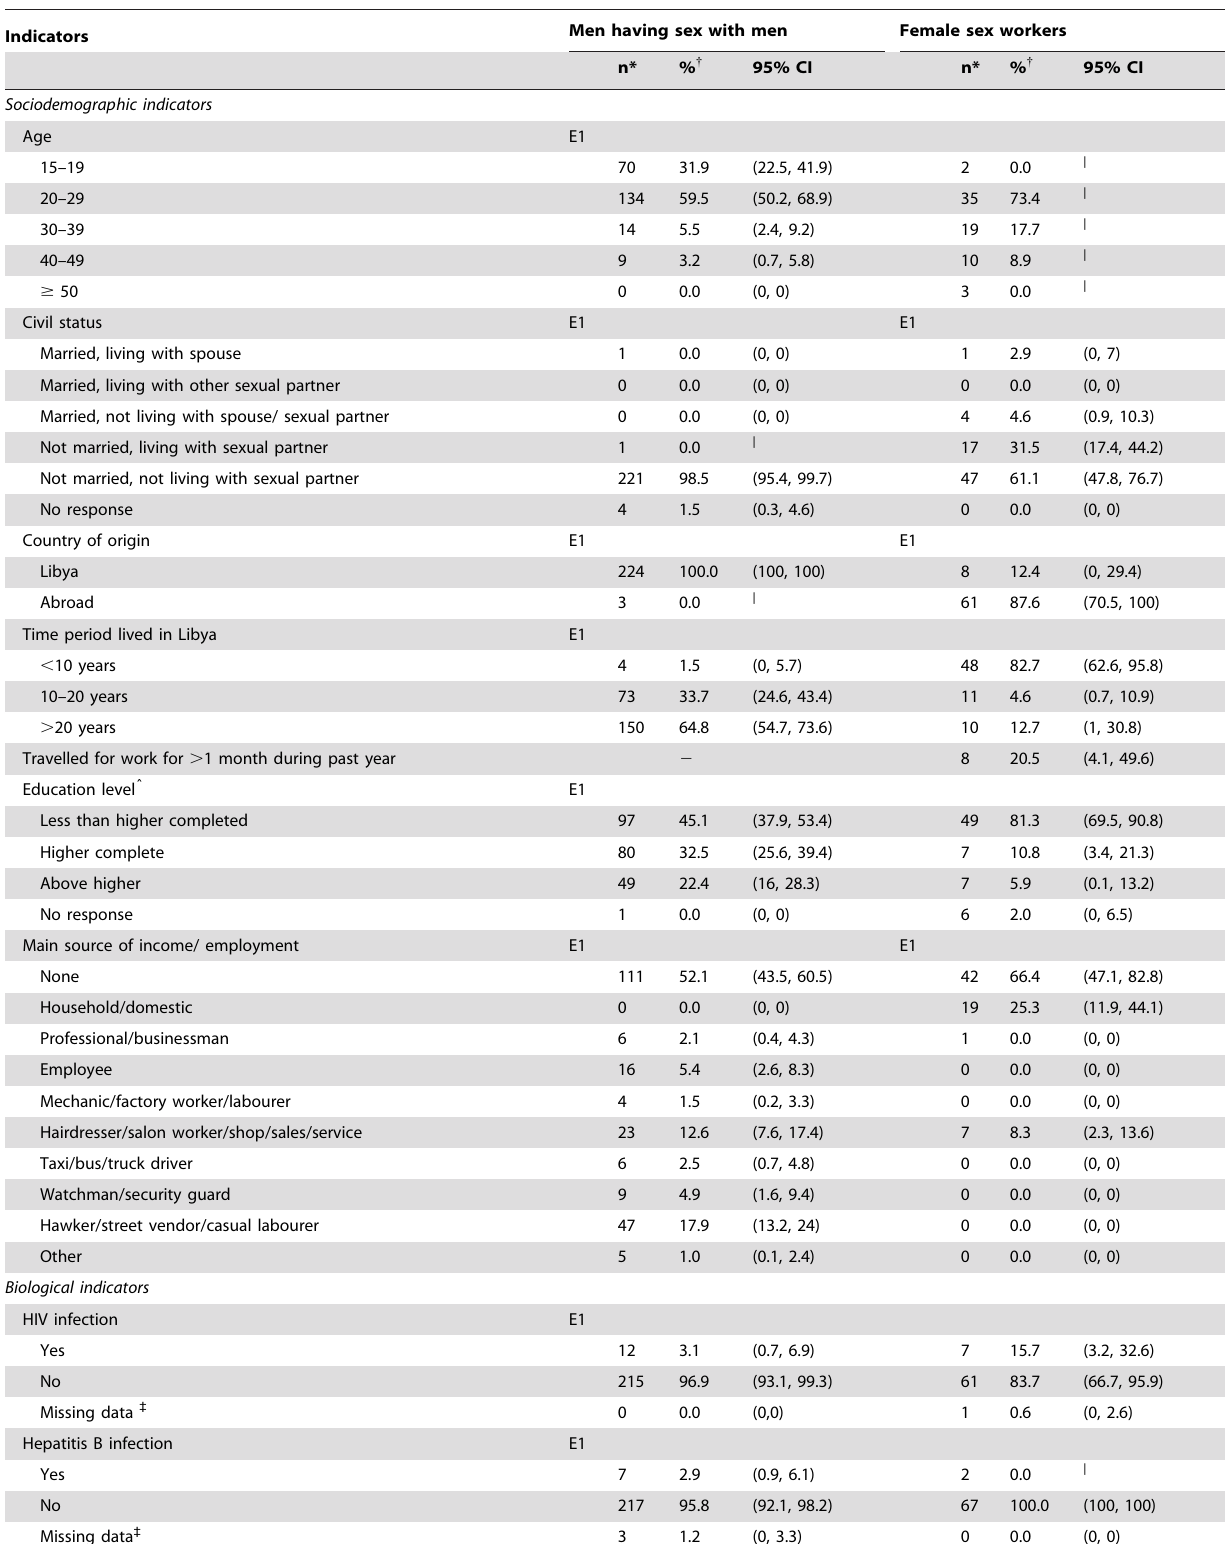
Table 1. Socio-demographic characteristics and prevalence of HIV and other infections among MSM and FSW in Tripoli, Libya, 2010.